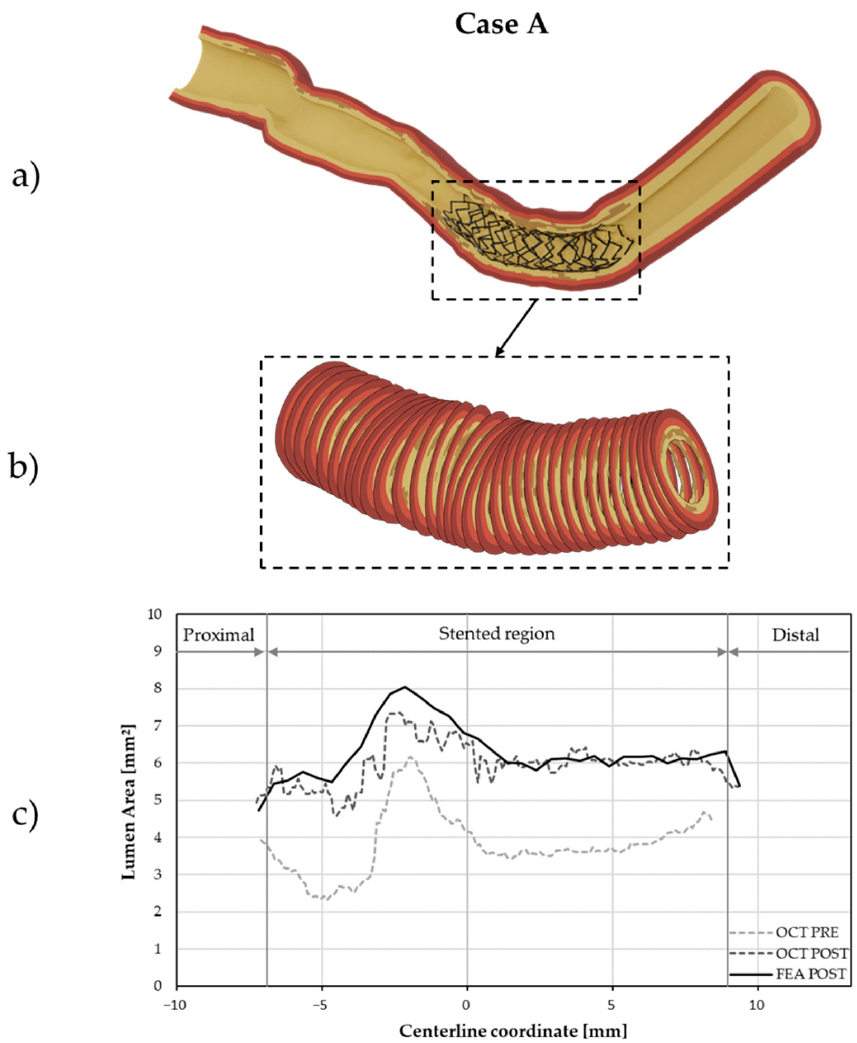
Figure 7. Numerical simulation results for the replication of Case A: ( a ) the geometry of artery section and stent at the end of clinical treatment; ( b ) slices orthogonal to the lumen centerline of the stented artery region used for lumen area measurements; and ( c ) graph of the lumen area as a function of the centerline coordinate with the curves related to the clinical data deduced from pre- and post-treatment OCTs and the FEA